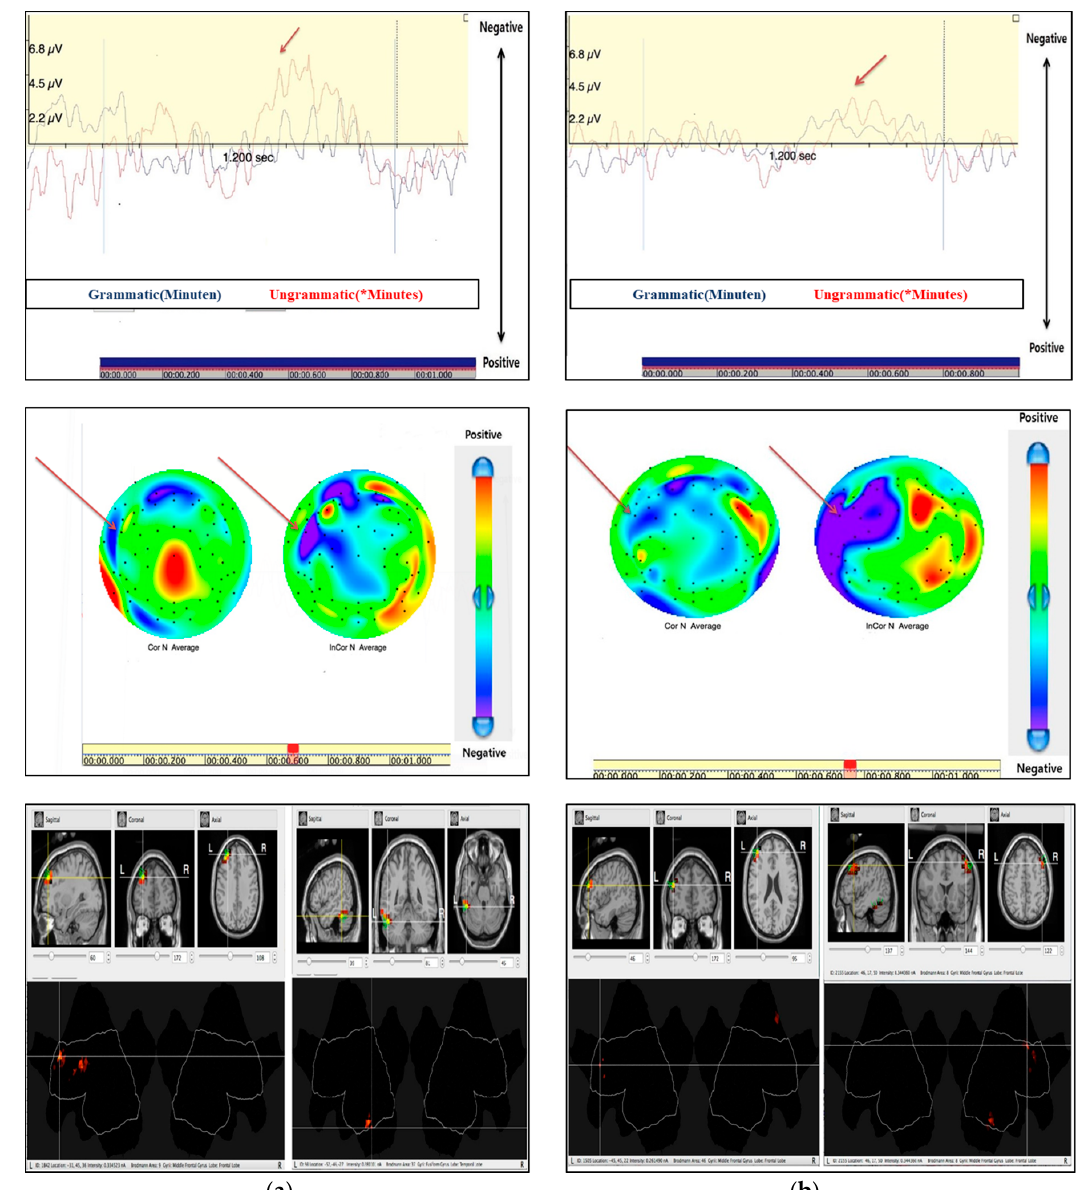
Figure 3. Left anterior negativity (LAN) (FT7) by regular ending violation between low ( a ) L2 and high ( b ) L2 learners.